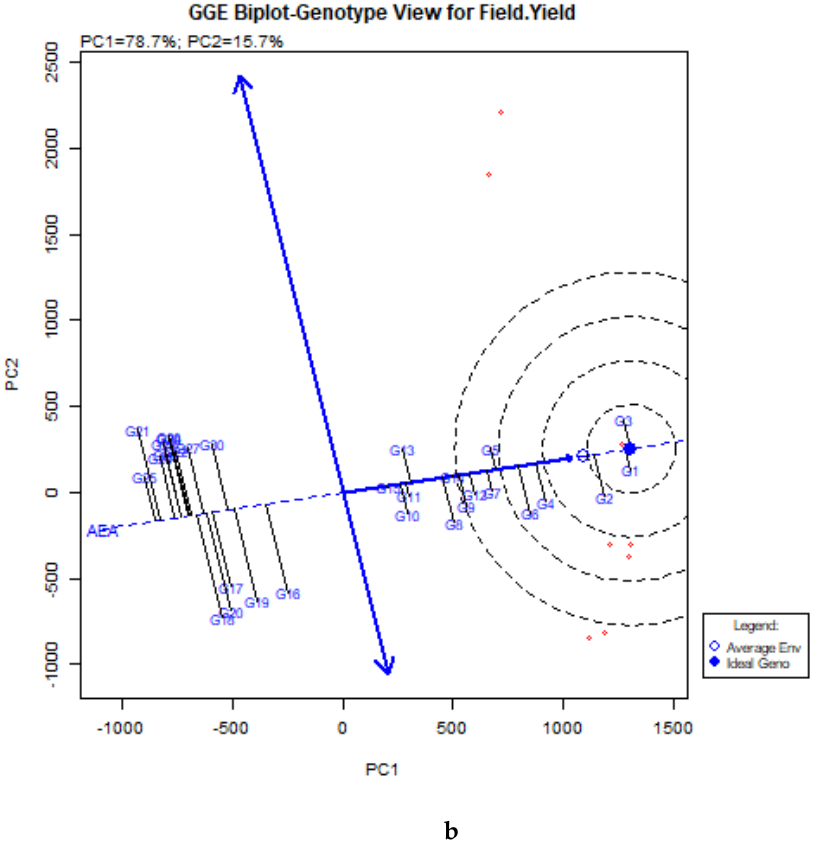
Figure 2. Stability analysis for seed yield (kg ha − 1 ) based on ( a ) the AMMI1 biplot where the Y -axis is the one visualizing the trait performance and the X -axis (PC1) visualizes the stability of varieties over environments, the E signs represent the environments combined with the years. The E1, E2, E3 and E4 are the environments Giannitsa, Florina, Trikala and Kalambaka, respectively for the year 2011 and the E5 to E8 are the same environments for the year 2012, G signs represent the genotypes used as follows PR31Y43 (G1), FACTOR (G2), COSTANZA (G3), ARMA (G4), PR31A34 (G5), ELEO-NORA (G6), FAMOSO (G7), DKC6818 (G8), MITIC (G9), DKC6040 (G10), KERMESS (G11), PR31G98 (G12), LG3535 (G13), PR33A46 (G14), PR31P41 (G15), 1T (G16), 2T (G17), 3T (G18), 4T (G19), 5T (G20), 1F (G21), 2F (G22), 3F (G23), 4F (G24), 5F (G25), 6F (G26), 7F (G27), 8F (G28), 9F (G29), 10F (G30); the stability of the varieties over environments where the productive varieties are those to the right on the AEA vector and the stable ones are those closest to the AEA axis as possible.